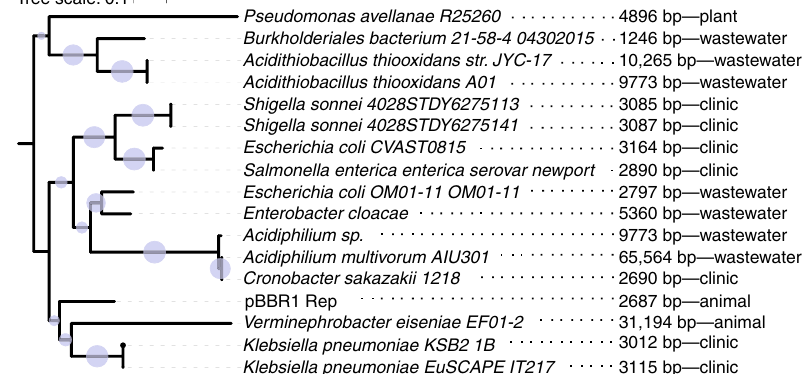
Fig. 5 Phylogeny of pBBR1 Rep protein. A search for homologs of pBBR1 revealed several plasmids having a homologous Rep protein ( ≥ 65% identical amino acids). Phylogenetic relations between the Rep homologs are depicted by the tree topology with blue circles whose size is proportional to the bootstrap support in each node. Plasmid size and isolation location are indicated next to the host taxonomic